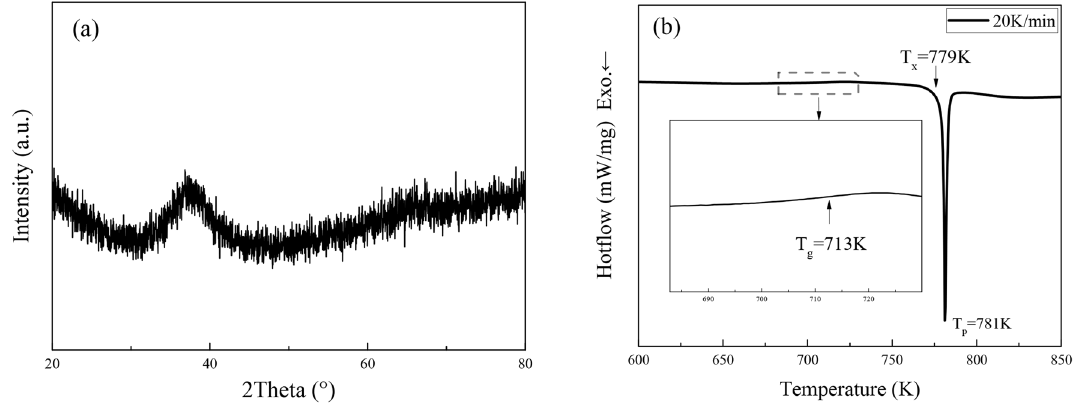
Figure 1. ( a ) XRD pattern and ( b ) DSC scan of Zr 55.7 Cu 22.4 Ni 7.2 Al 14.7 alloy